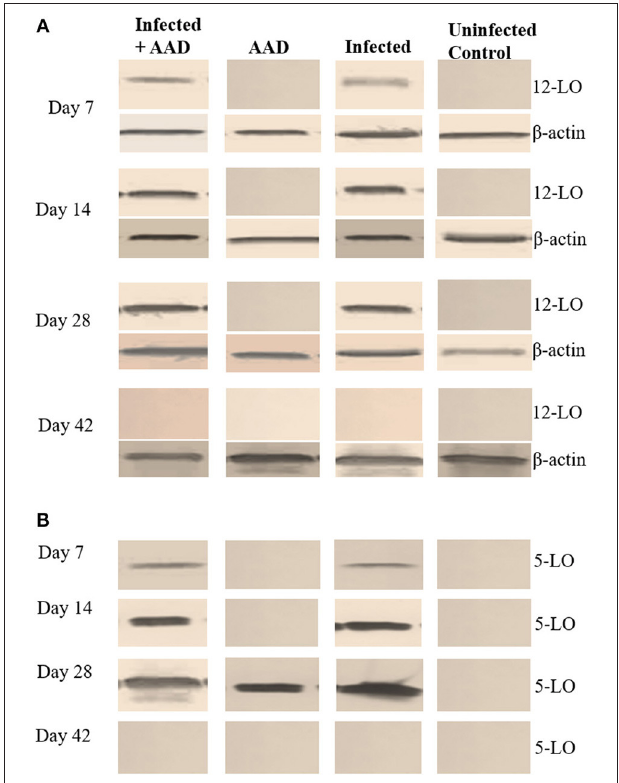
FIGURE 7 | 5-LO and 12-LO Western Blot of mouse lung tissue . The12-LO (76kDa) protein was present in infected lung tissue from days 7 to 28. However, it undetectable in the AAD only and uninfected animals (A) . 5-LO (79kDa) protein was detected in the lung tissue of infected animals on days 7 through 28, as well as AAD induced animals on day 28 following induction of AAD with Ova (B) .